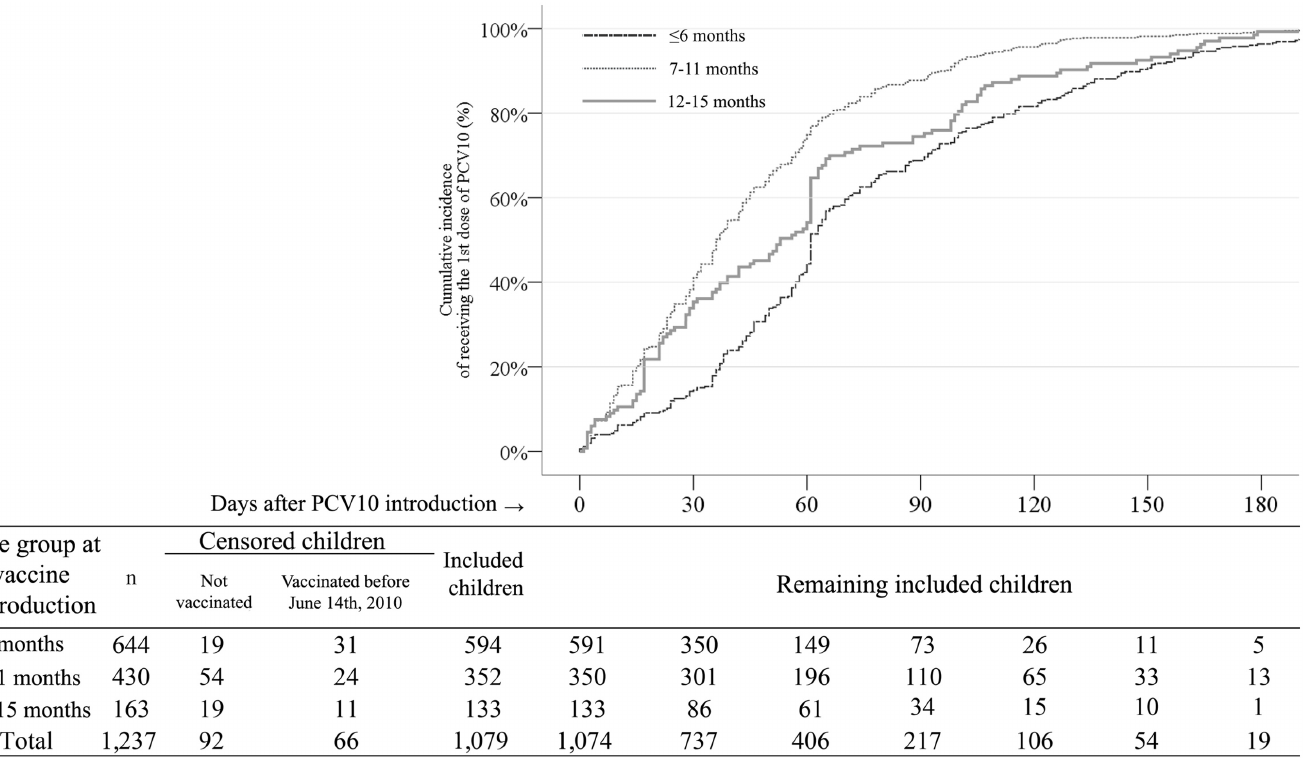
Fig 3. Kaplan-Meier curves of incidence for the first dose of PCV10 after its introduction in the routine immunization program. Goiania, December 2010 to February 2011.